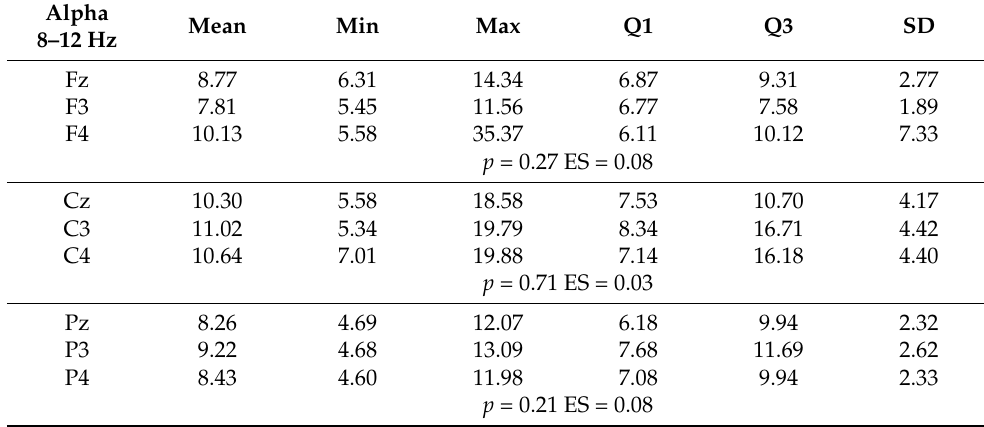
Table 4. Descriptive statistics of Alpha waves from all channels ( µ